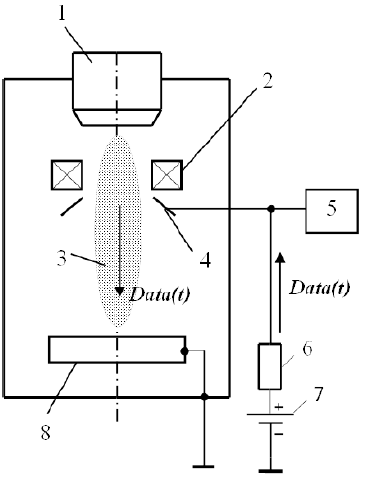
Figure 1. Scheme of plasma charge current registration: 1—electron gun, 2—focusing lens, 3—plasma formed over the area of electron beam welding, 4—electron collector, 5—a system of registration, 6—load resistor, 7—a source of bias, 8–—work piece, Data(t) —secondary current